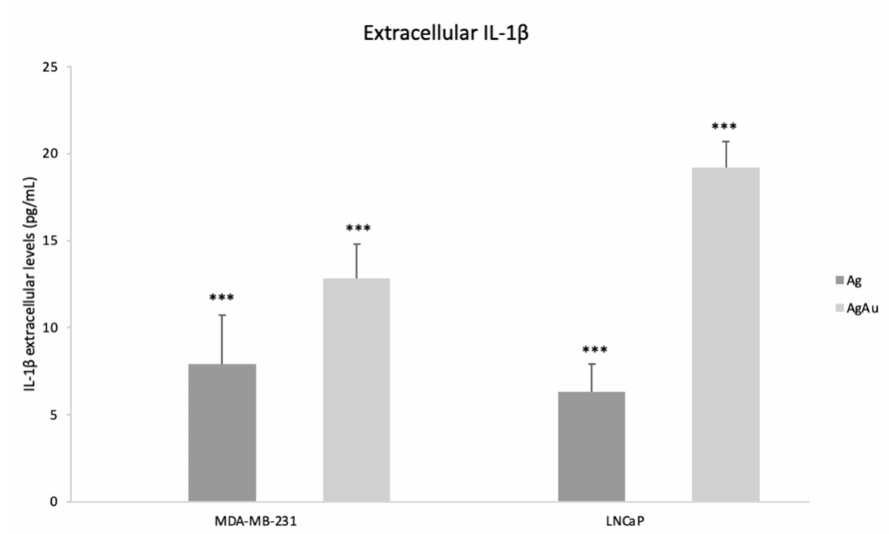
Figure 5. Extracellular levels of IL-1 β per cell line, after incubation with 50 µ g/mL of Ag, AgAu of MDA-MB-231 and LNCaP cells. The *** symbol shows statistical significance using one way ANOVA ( p < 0.05) compared to untreated cells. In every other cell line and conditions (Ag, Au and AgAu NPs and no NP treatment), no extracellular IL-1 β was